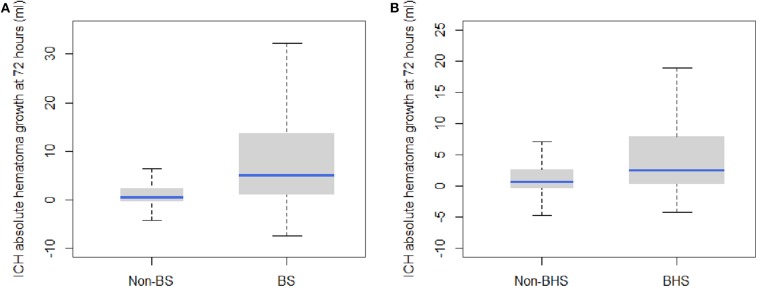
Box plots of hematoma growth between the baseline and 72-h CT scans depict a greater hemorrhage volume growth in (A) the BS vs. non-BS scans (P < 0.001) and (B) the BHS vs. non-BHS scans (P < 0.001). BHS, black hole sign; BS, blend sign; CT, computed tomography.